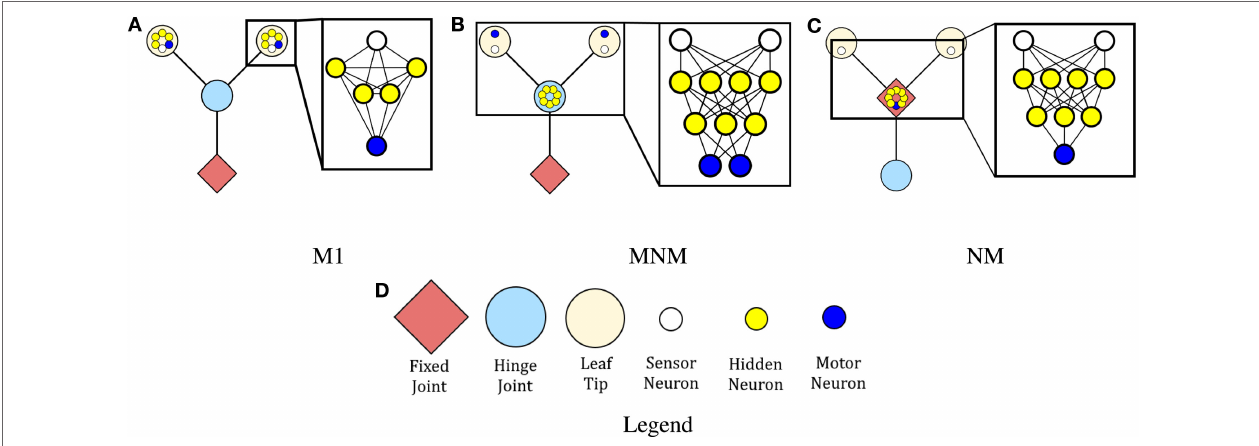
FIGURE 1 | The controllers and morphologies for each of the three robots . The red diamonds indicate that branches connected at that position are fixed relative to one another. Large blue circles indicate that the branches rooted at the circles are free to move independently of one another. Beige circles represent leaf tips. The small circles represent neurons: blue neurons represent motor neurons, white neurons represent sensor neurons, and yellow neurons represent hidden neurons. The modular robot is represented by (A) on the left, the mod-non-modular (B) is in the middle, and the non-modular robot is represented by (C) on the right. Blow ups of the network structure are included. All hidden neurons and motor neurons have recurrent self-connections, which are not depicted. Further, all connections except those with the sensor neurons are two-way. (D) is a legend showing the various types of joints and neurons.